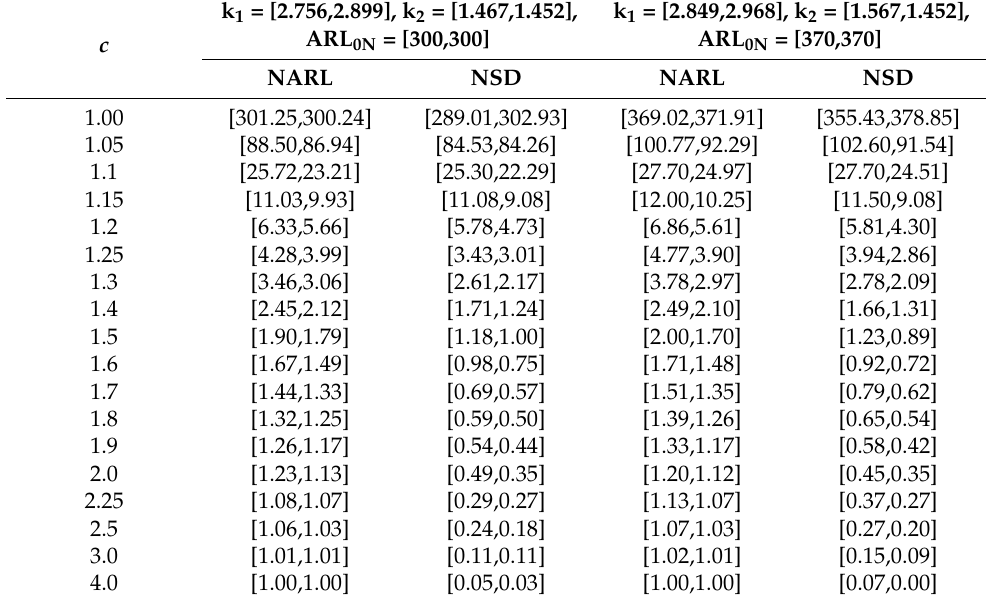
Table 4. The NARL when n N (cid:101) [8,10] and I λ U = 0.3.